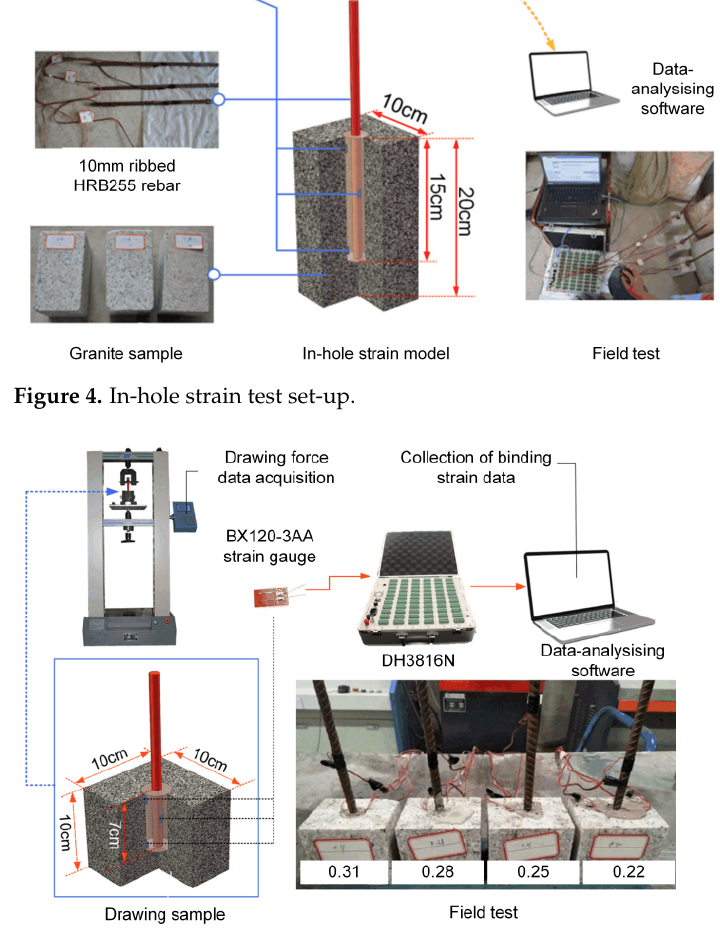
Figure 4. In-hole strain test set-up.